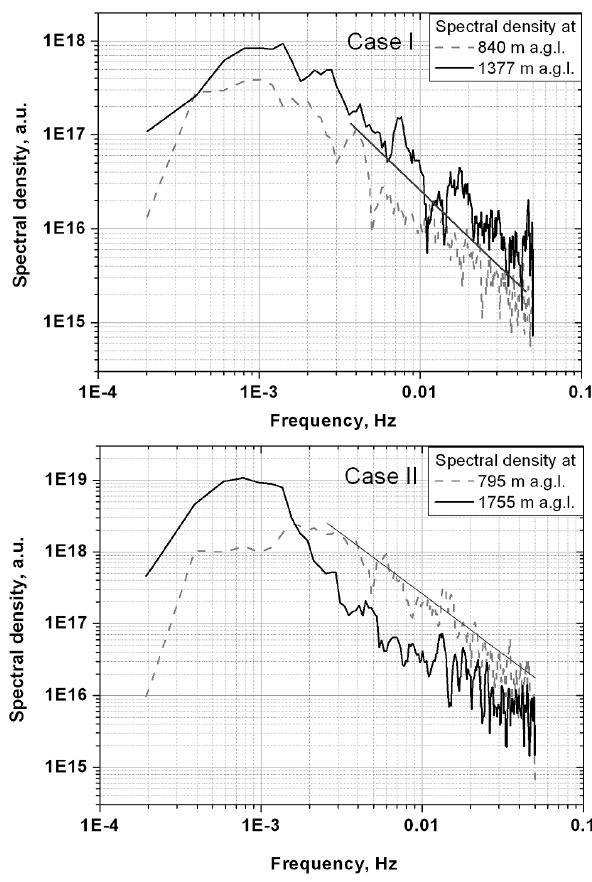
Fig. 9. Spectra of relative particle backscatter coefficient at two different heights for Case I (top) and Case II (bottom). The expected − 5/3-slope of the inertial subrange is shown in each